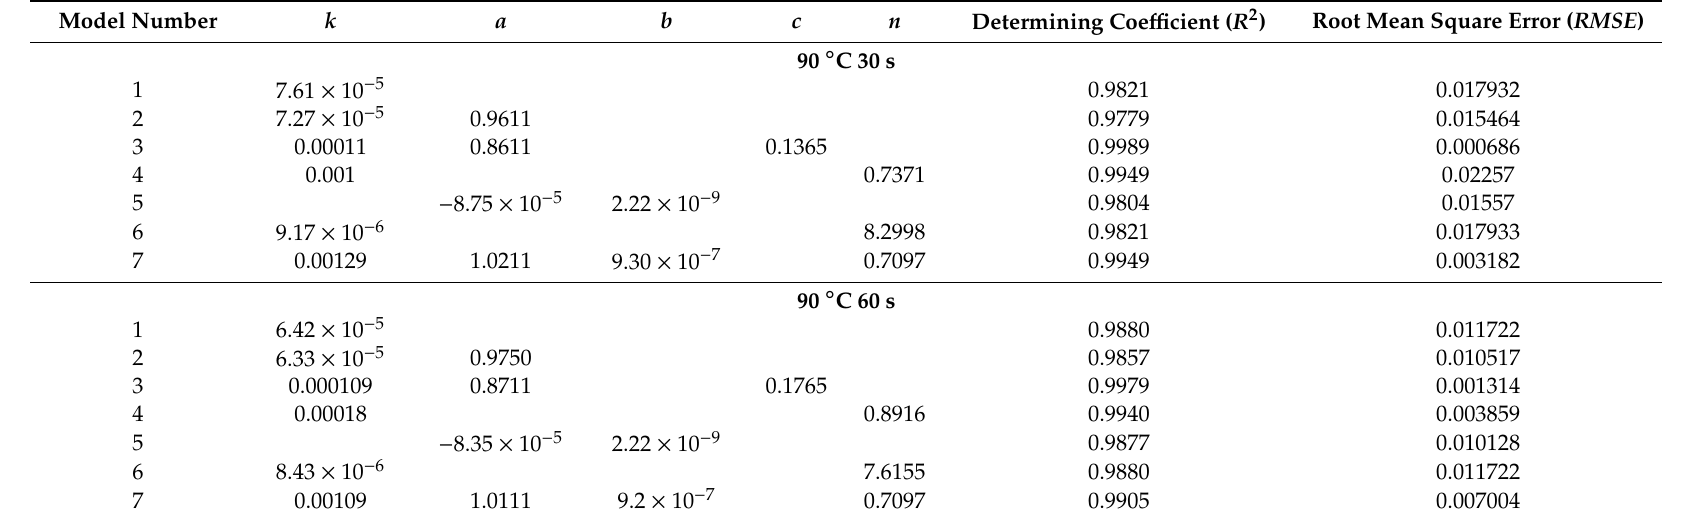
Table 4. Curve fitting criteria for various mathematical models and parameters for blanched and unblanched pomegranate arils cv.